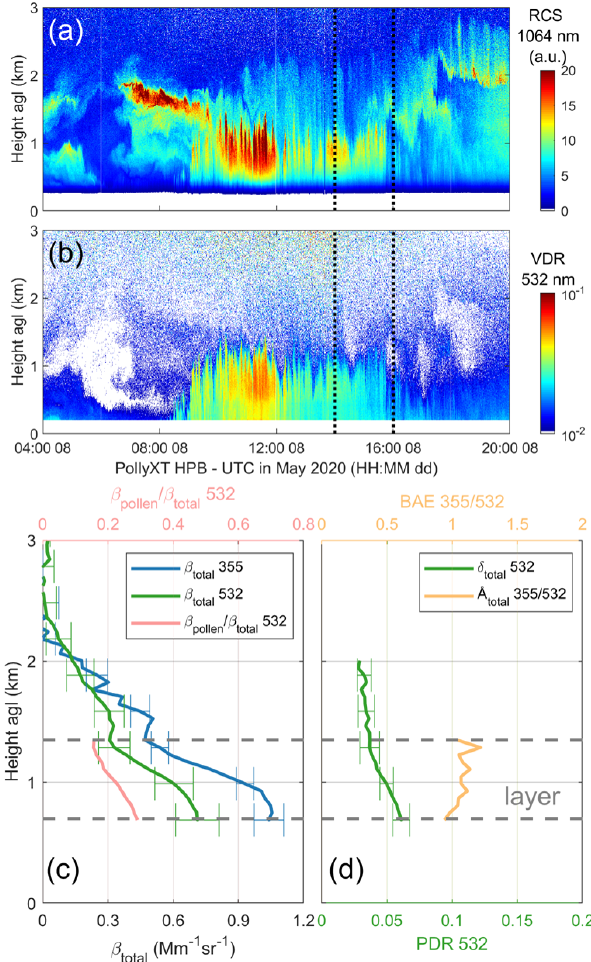
Figure 5. Case example in period no. 1 of Hohenpeißenberg sta- tion. Time–height cross section of (a) range-corrected signal (RCS) at 1064nm and (b) volume depolarization ratio (VDR) at 532nm from Polly XT . Vertical profiles of (c) particle backscatter coef- ficients and the pollen backscatter contribution; (d) backscatter- related Ångström exponent (BAE) and the particle linear depolar- ization ratio (PDR) of the selected time period (black dotted box in a, b ). Selected layer is shown between grey dashed lines in (c) and (d) .